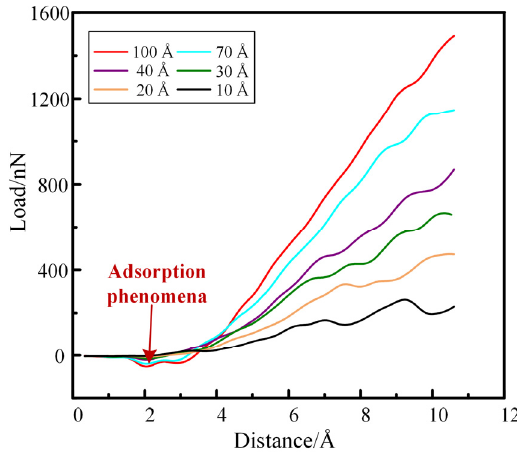
Figure 4. Load-Distance curve simulated by nanoindentation after smoothing treatment. 10 Å, 20 Å, 30 Å, 40 Å, 70 Å and 100 Å in the figure represent the radius of the diamond indenter in the simu- lation.